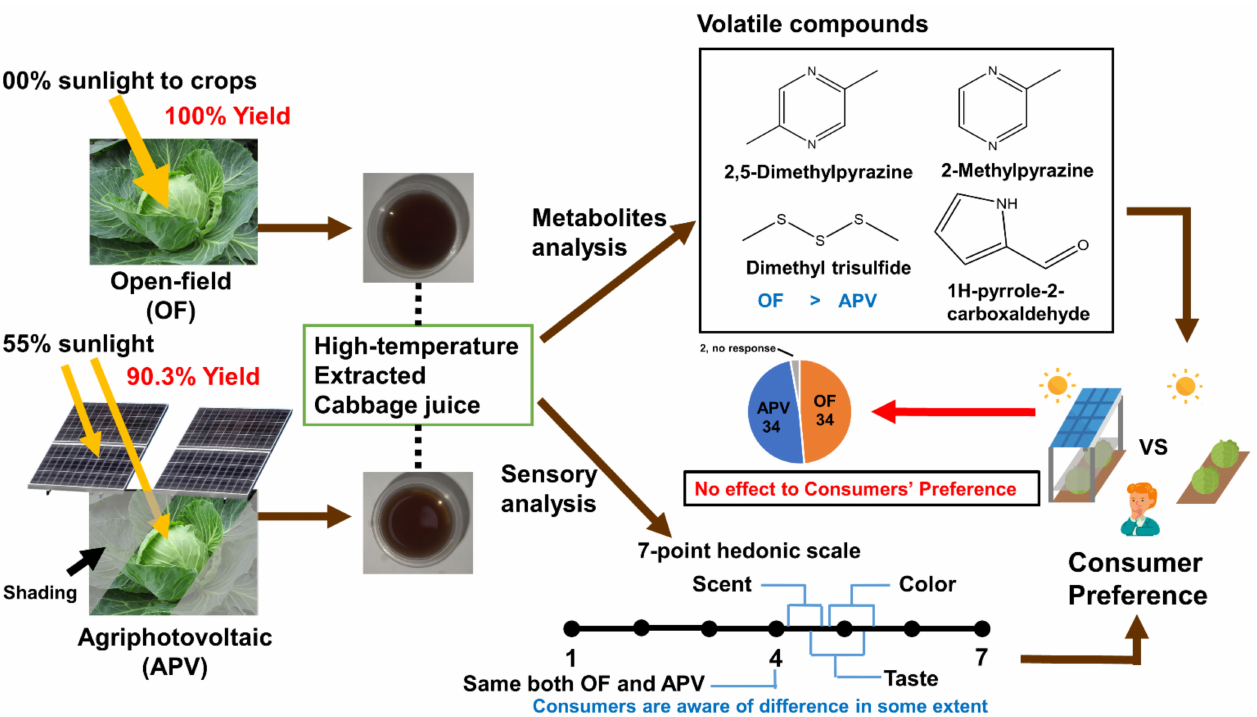
Figure 6. Overall scheme of the experiment. Cabbages were cultivated in conventional open-field conditions and under an agriphotovoltaic system. When the harvest of cabbage grown in OF was 100%, cabbage grown from APV showed a yield of 90.3%. Harvested cabbages were extracted at high temperatures (boiling). Metabolomic approach was utilized for both fresh cabbage and cabbage juice, but only cabbage juice was used for sensory evaluation. Some volatile compounds concentrations were higher in OF than APV. The result of the attribute test showed consumers are aware of the difference between the samples. However, it did not affect the overall consumer preference.